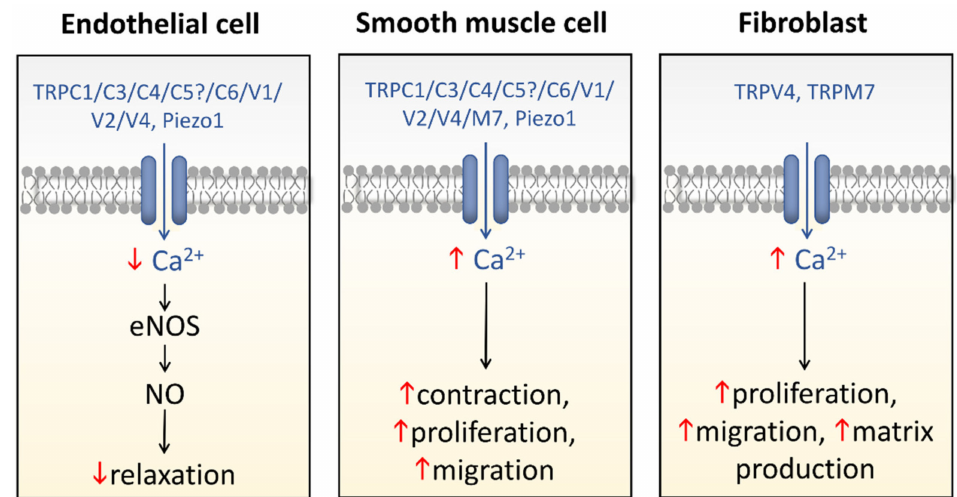
Figure 5. Schematic view illustrating the multifunctional contribution of SAC in the pathogenesis of PH. Red arrows indicate PH-induced modifications of cellular processes in pulmonary arterial vascular